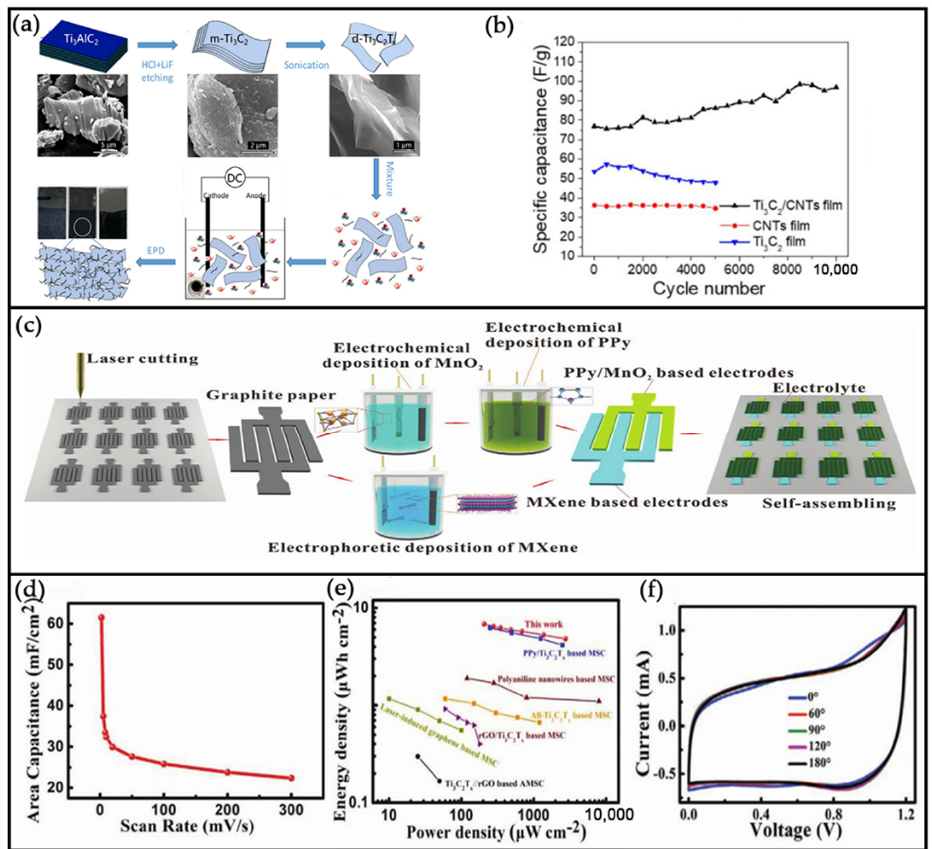
Figure 16. ( a ) Schematic diagram of the preparation route of electrode films using the EPD method. ( b ) The plots of the specific capacitance of the three electrodes after 10,000 GCD cycles at 5 A g − 1 . Reprinted with permission from Ref. [191]. Copyright 2018 Journal of Electroanalytical Chemistry . ( c ) The schematic representation of the fabrication route of the flexible Ti 3 C 2 T x //PPy/MnO 2 -based AMSC. ( d ) The ACs of the Ti 3 C 2 Tx//PPy/MnO 2 -based AMSC at 2–300 mV s − 1 . ( e ) A Ragone plot of Ti 3 C 2 T x //PPy/MnO 2 -based AMSC compared to previously reported MSCs. ( f ) The CV curves of the AMSC under 0–180 ◦ bending conditions at 10 mV s − 1 . Reprinted with permission from Ref. [192]. Copyright 2020 WILEY-VCH Verlag GmbH & Co., KG. Table 2. Comparison of the electrochemical performance of MXene-based flexible SCs.